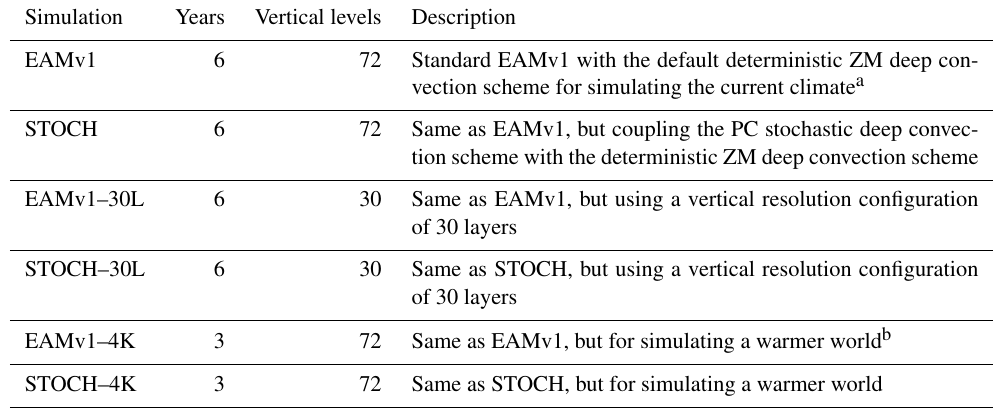
Table 1. List of simulations. Simulation Years Vertical levels Description EAMv1 6 72 Standard EAMv1 with the default deterministic ZM deep con- vection scheme for simulating the current climate a STOCH 6 72 Same as EAMv1, but coupling the PC stochastic deep convec- tion scheme with the deterministic ZM deep convection scheme EAMv1–30L 6 30 Same as EAMv1, but using a vertical resolution configuration of 30 layers STOCH–30L 6 30 Same as STOCH, but using a vertical resolution configuration of 30 layers EAMv1–4K 3 72 Same as EAMv1, but for simulating a warmer world b STOCH–4K 3